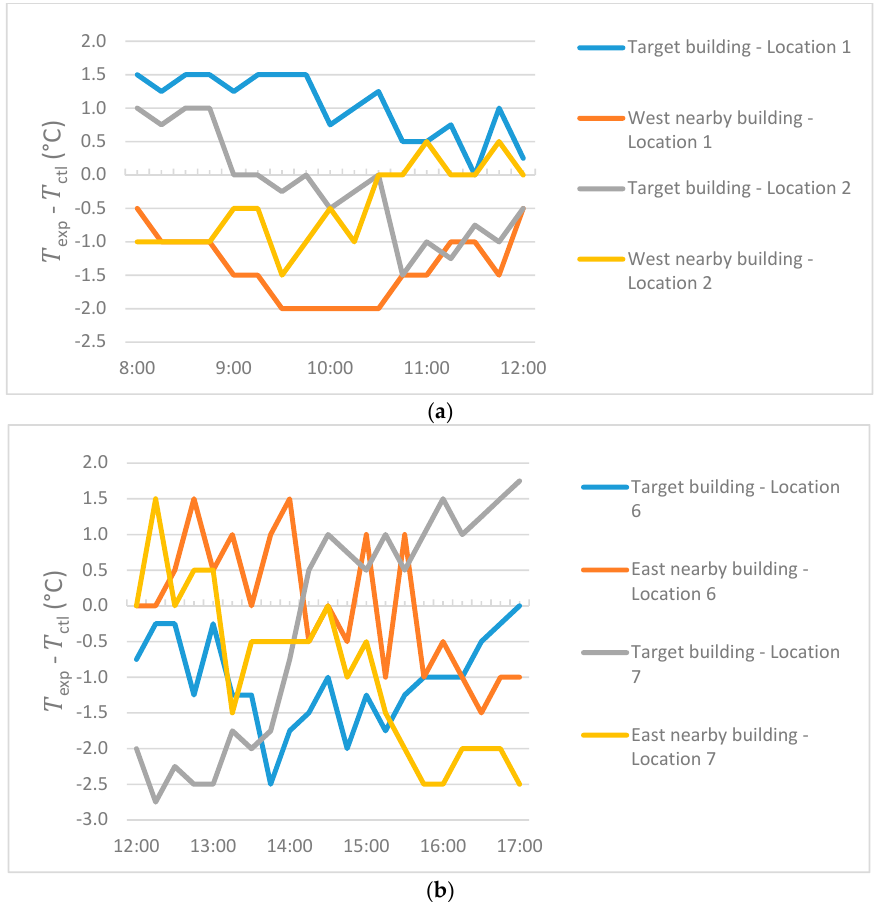
Figure 9. Cooling effect of tree shade on the surrounding building facade temperature (One-tree). ( a ) Morning shading to the west nearby building; ( b ) Afternoon shading to the east nearby building.